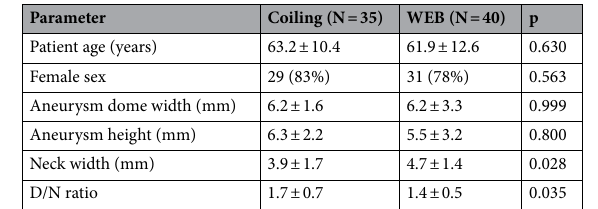
Table 1. Baseline patient demographics and aneurysm characteristics. D/N ratio dome/neck